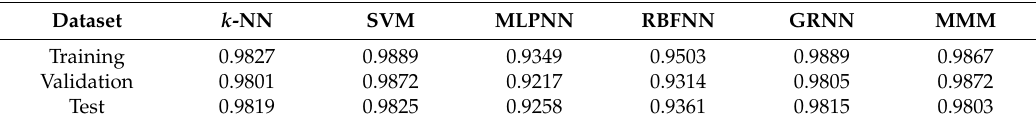
Table 4. R-square values of different algorithms for training, validation, and test dataset. In the table k -NN, SVM, MLPNN, RBFNN, GRNN, and MMM are abbreaviated forms of k -nearest neighbor, support vector machine, multilayer perceptron neural network, radial basis function neural network, generalized regression neural network, and minimum-maximum-mean,